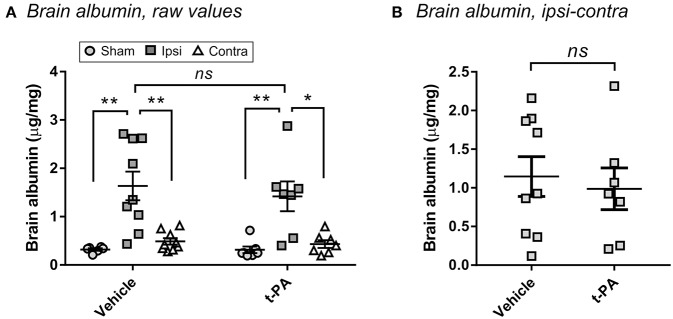
t-PA does not intensify blood-brain barrier (BBB) disruption when administered 1 h post-stroke. Albumin levels in the perfused brain 23 h after administration at reperfusion of HEPES vehicle or mouse t-PA (mt-PA; 0.9 mg/kg) to C57Bl/6 mice undergoing sham surgery or transient MCAo (1 h). Data is presented either as raw values (μg albumin per mg brain protein; A) or as corrected values (MCAo mice only after subtraction of the contralateral from the ipsilateral level to correct for perfusion efficiency; B). Stroke induces significant albumin accumulation in the injured hemisphere, indicative of BBB disruption, however no differences are observed between vehicle and mt-PA at this early time point. Data is shown as individual animals with mean ± SEM. n = 6 for sham vehicle, 7 for sham t-PA, 9 for MCAo vehicle, 7 for MCAo t-PA. *p < 0.05, **p < 0.01, ns, not significant by student t-test.